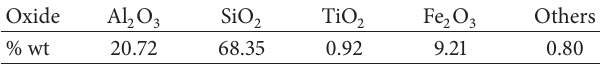
Table 1: Chemical composition of diatomite analyzed by